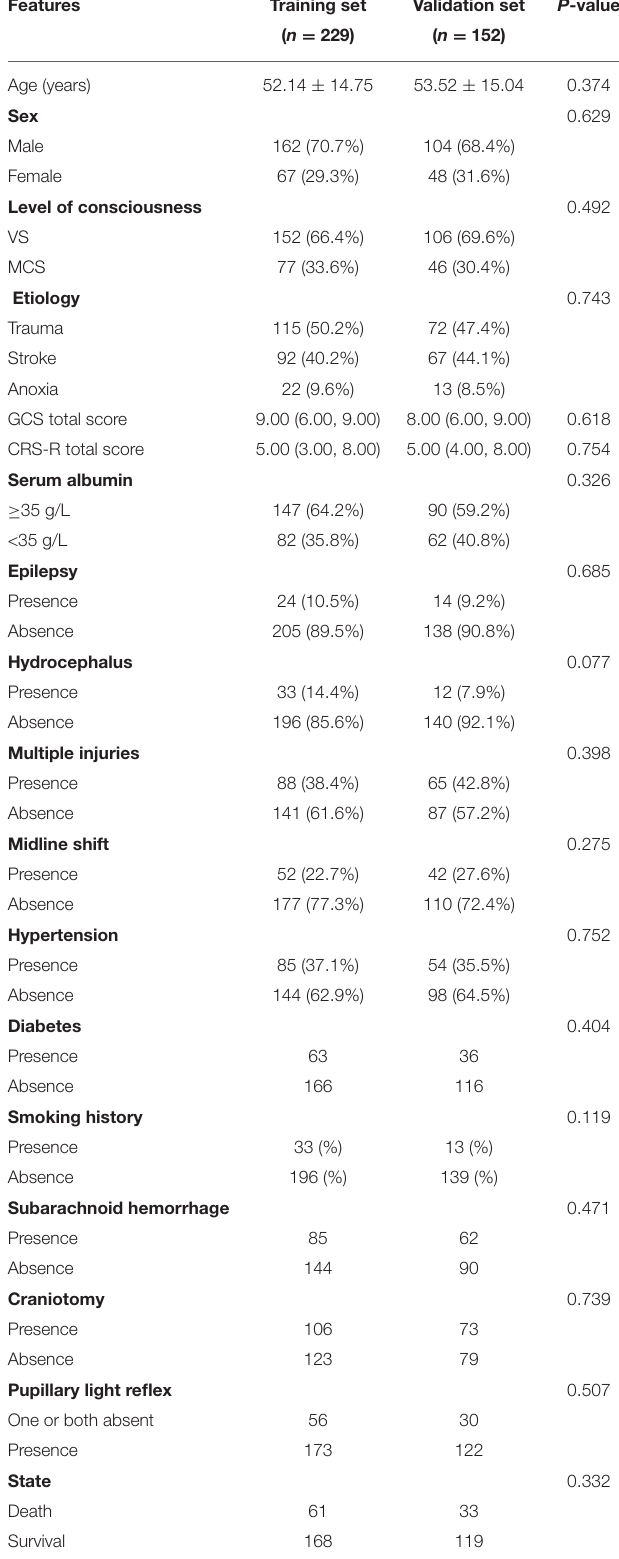
TABLE 1 | Comparison of baseline data between the training set and validation